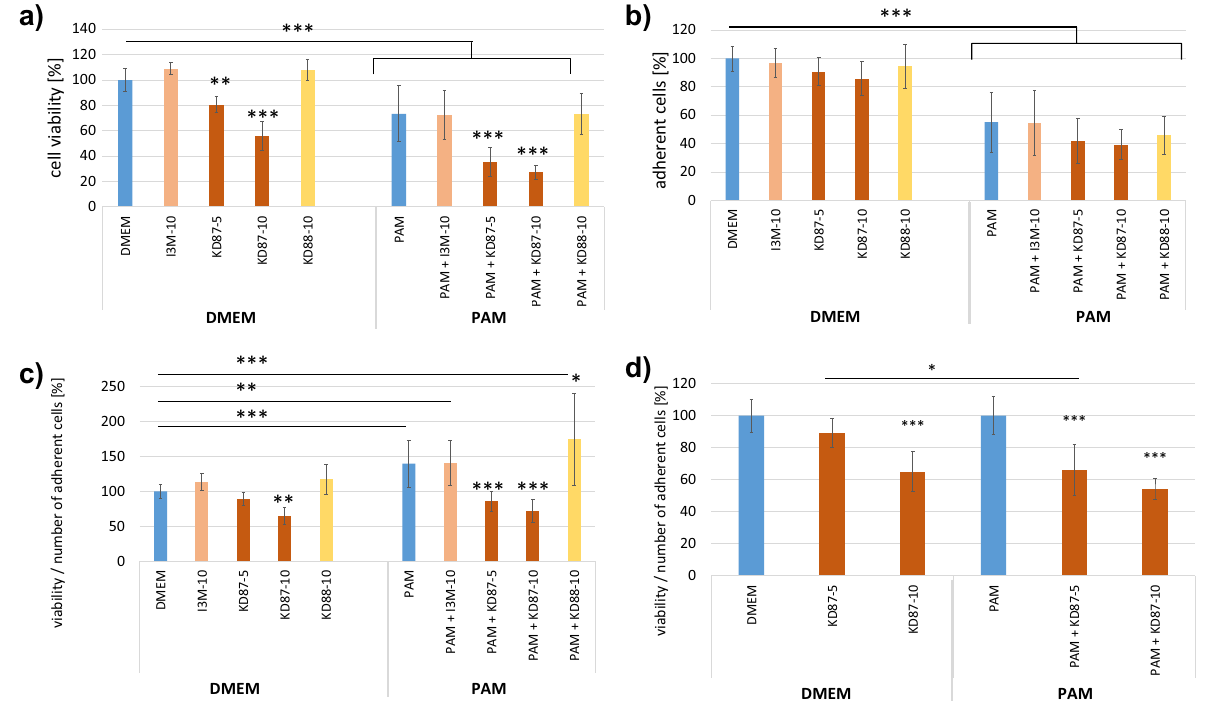
Figure 2. Viability and cell number of A375 cells after the combination of PAM and small molecules. ( a ) Cell viability was significantly reduced by the combination of PAM + KD87-5 (5 µM) and KD87-10 (10 µM). ( b ) PAM led to a significant cell detachment. ( c ) Viability of the remaining adherent cells is shown with mean values normalised to the DMEM control. While PAM increased viability of the remaining adherent cells, treatment with KD87 decreased it. ( d ) The combination of PAM and KD87 5 µM caused a significant loss of viability of the remaining adherent cells, indicating a synergistic effect. The mean values of DMEM and PAM are set 100%. (Tukey’s multiple comparisons test, * compared with the respective control (blue columns); n = 3, mean ±